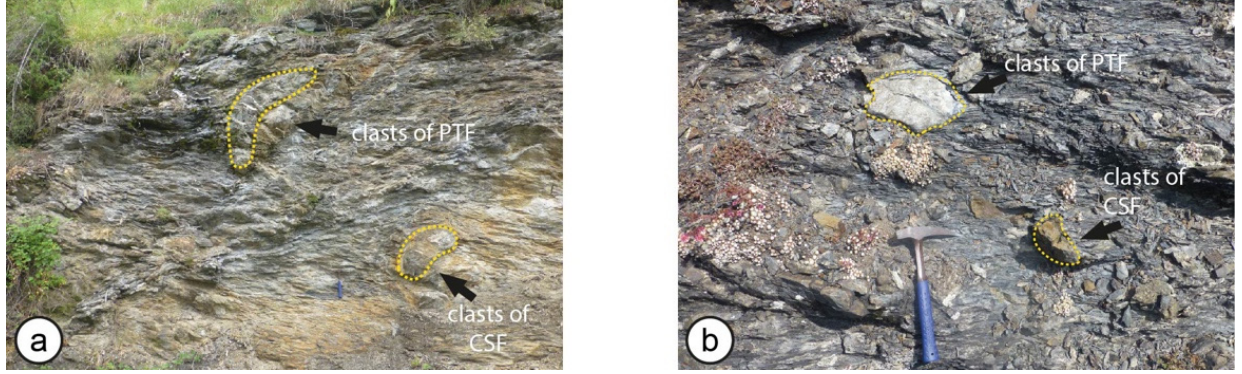
Figure 4. ( a , b ) Outcrop view of the Moglio Formation chaotic deposits. The orange dashed lines mark the boundary between the different clasts and the matrix. PTF: Pieve di Teco Formation; CSF: Cesio Formation.